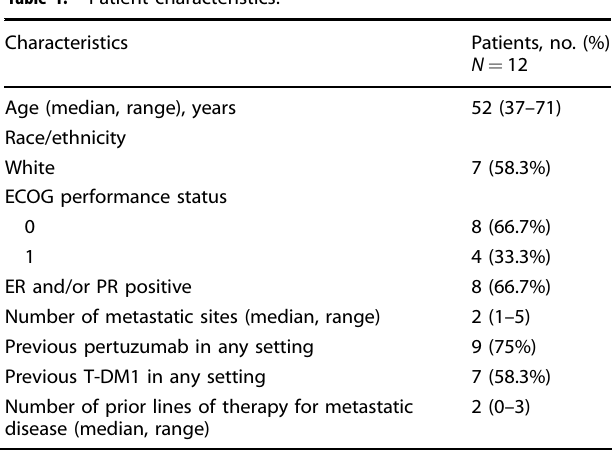
Table 1. Patient